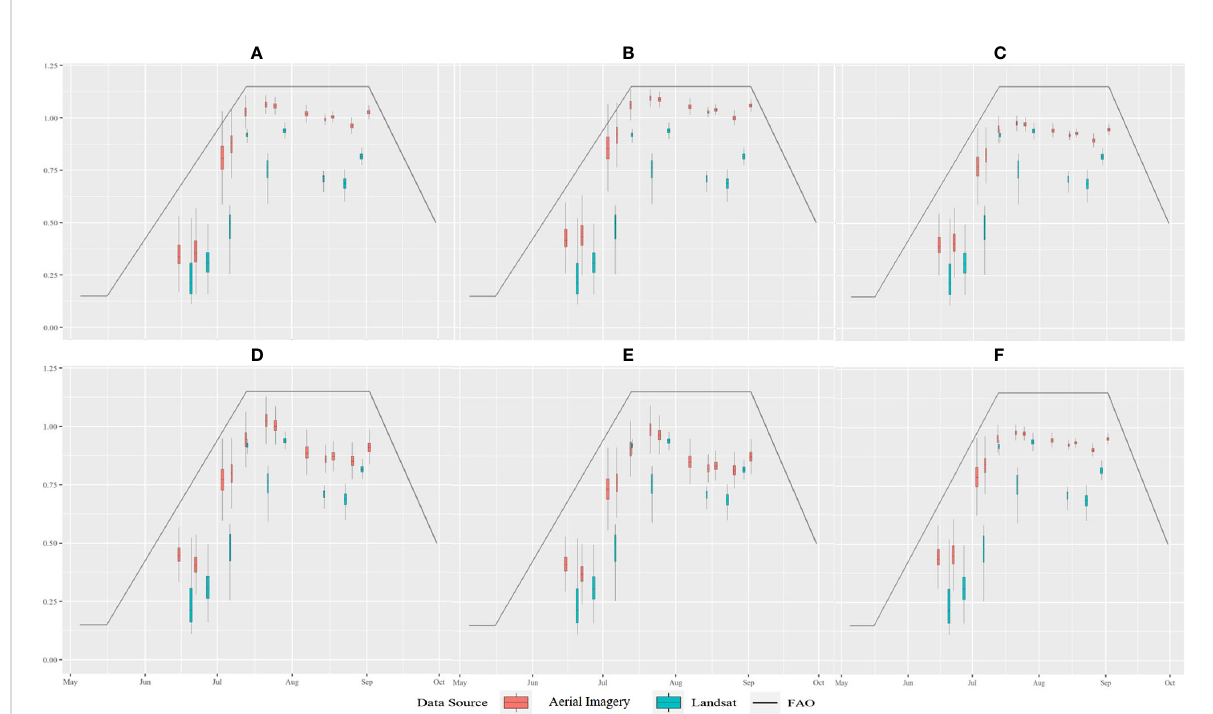
FIGURE 3 Boxplots of crop coef fi cients at Field B from Landsat and Aerial Imaging. Crop coef fi cients were estimated from equations developed by (A) Kamble et al. (2013), (B) Bausch and Neale (1987), (C) Bausch and Neale (1987), (D) Bausch (1993), (E) Campos et al. (2017), and (F) Neale et al.,